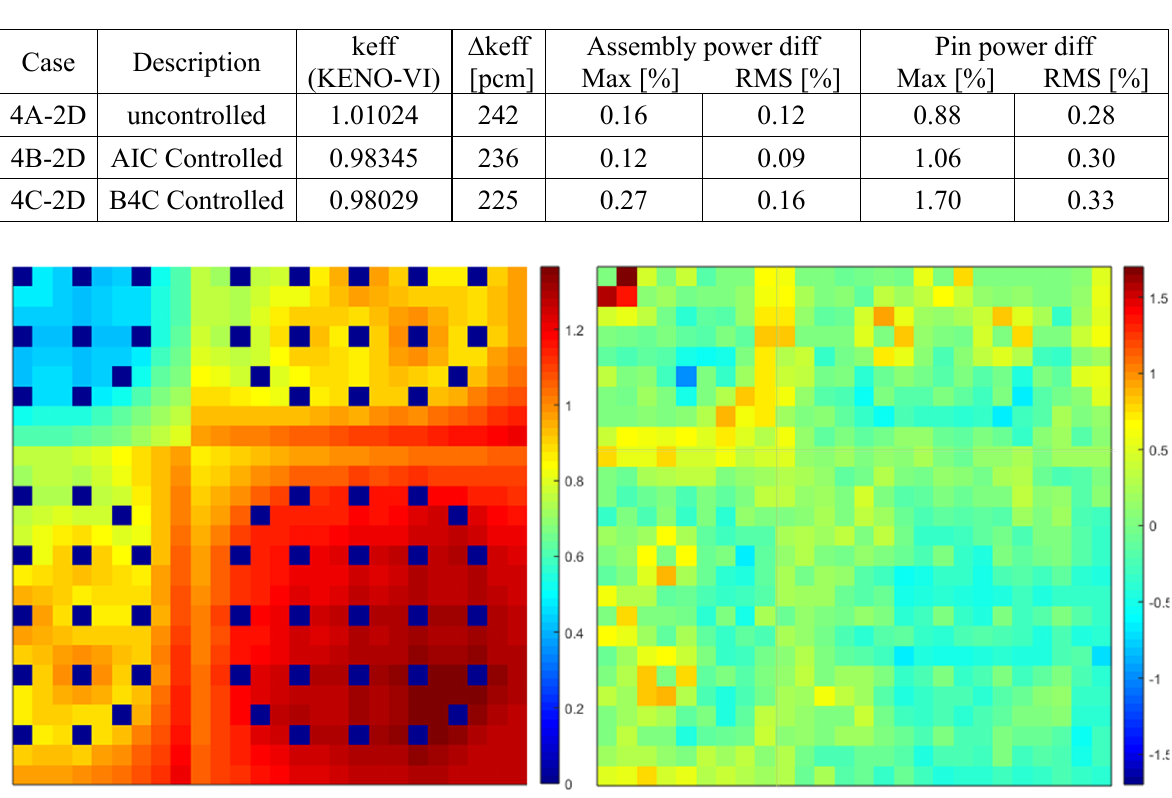
Table IV. Calculation result of 2D 3x3 multi-assembly.